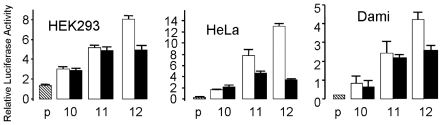
Transcriptional activity of ITGA2 promoter-luciferase reporter constructs transfected into HEK293, HeLa, or Dami cells.A luciferase reporter assay was used to compare transcriptional activity in the presence of -52C (white bars) or -52T (black bars) within the ITGA2 5′-regulatory region (from −1793 to +56) containing (CA)10 (10), (CA)11 (11) or (CA)12 (12) repeat sequences (abscissa). The plasmid vector (p) lacking an insert served as a baseline (negative) control. Relative luciferase activity is indicated on the ordinate. The mean ± SD of three experiments is represented.